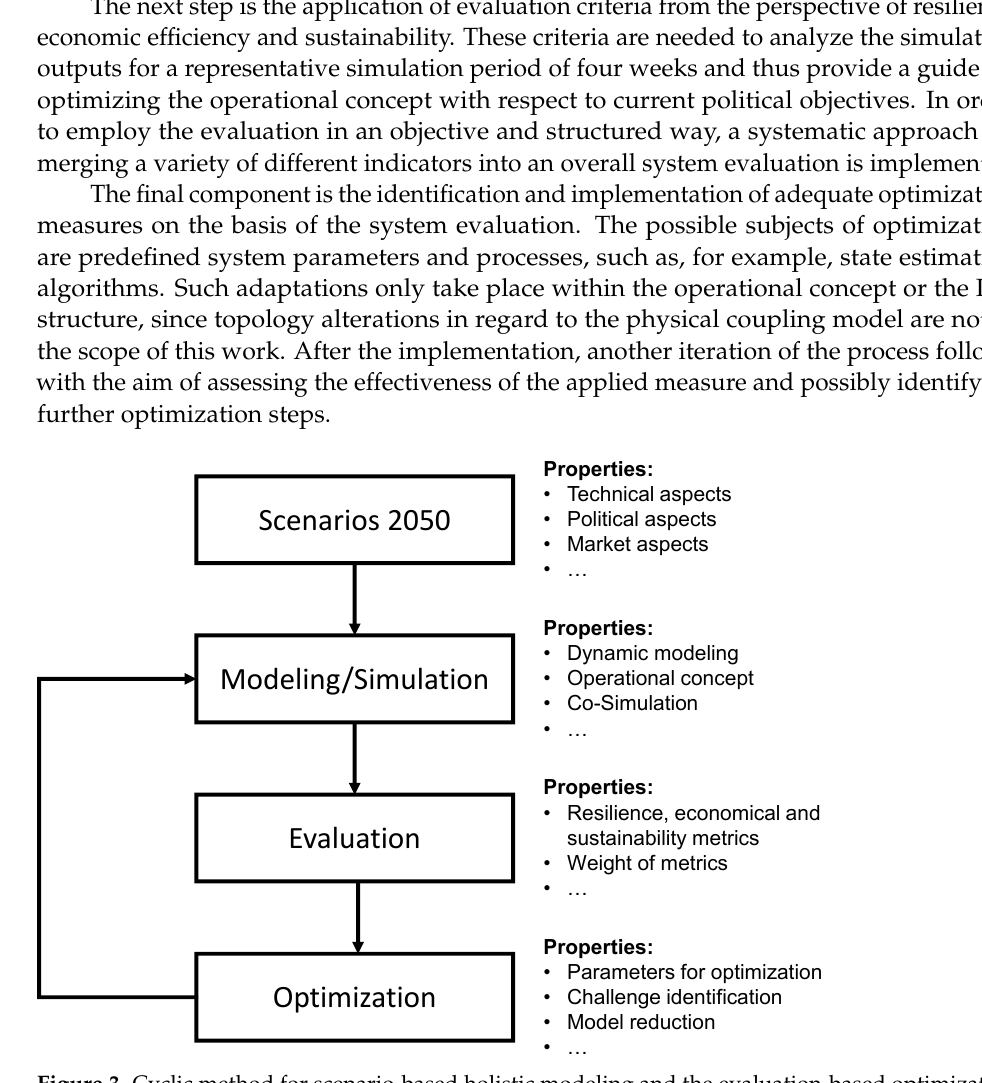
Figure 3. Cyclic method for scenario-based holistic modeling and the evaluation-based optimization of operational